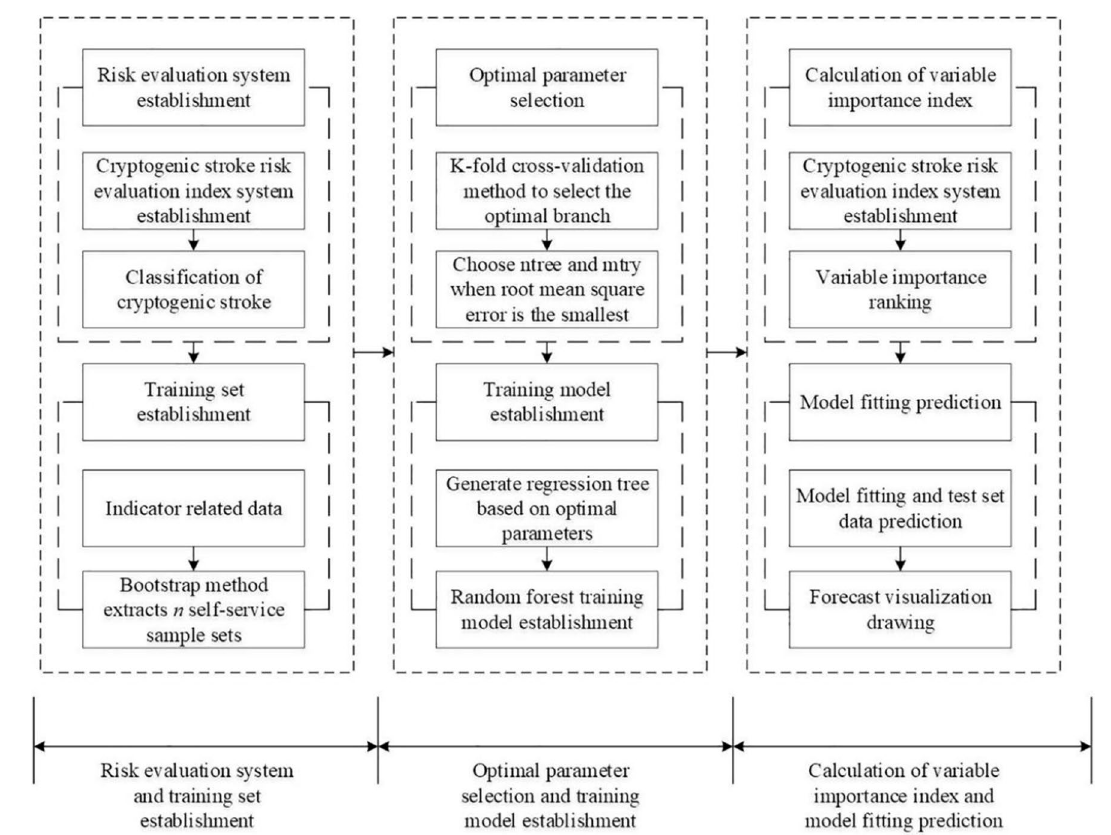
Fig. 5 Flow diagram of the random forest regression model on cryptogenic stroke